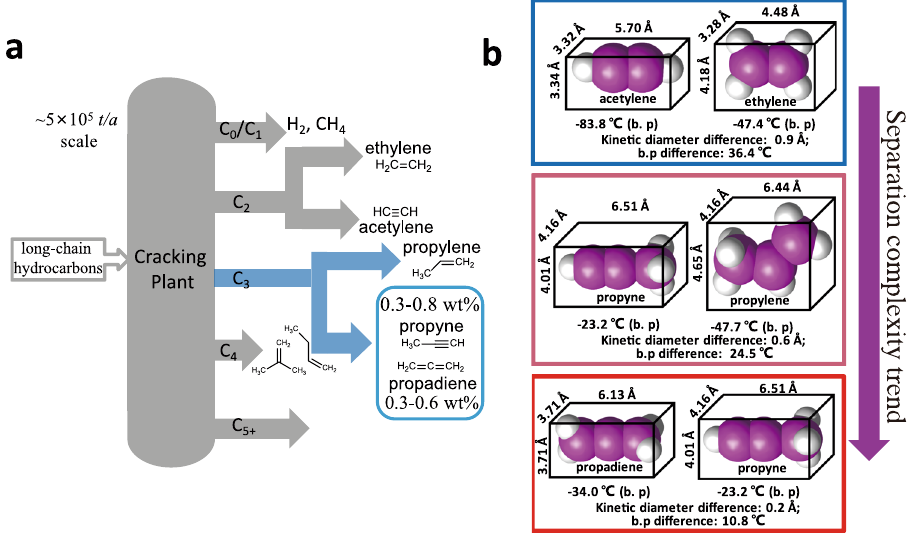
Fig. 1 The major sources and separation complexity of light hydrocarbons. a Schematic diagram of the hydrocarbon cracking process. b Comparison of molecular size, kinetic diameter, and b.p difference of acetylene and ethylene, propyne and propylene and propyne and